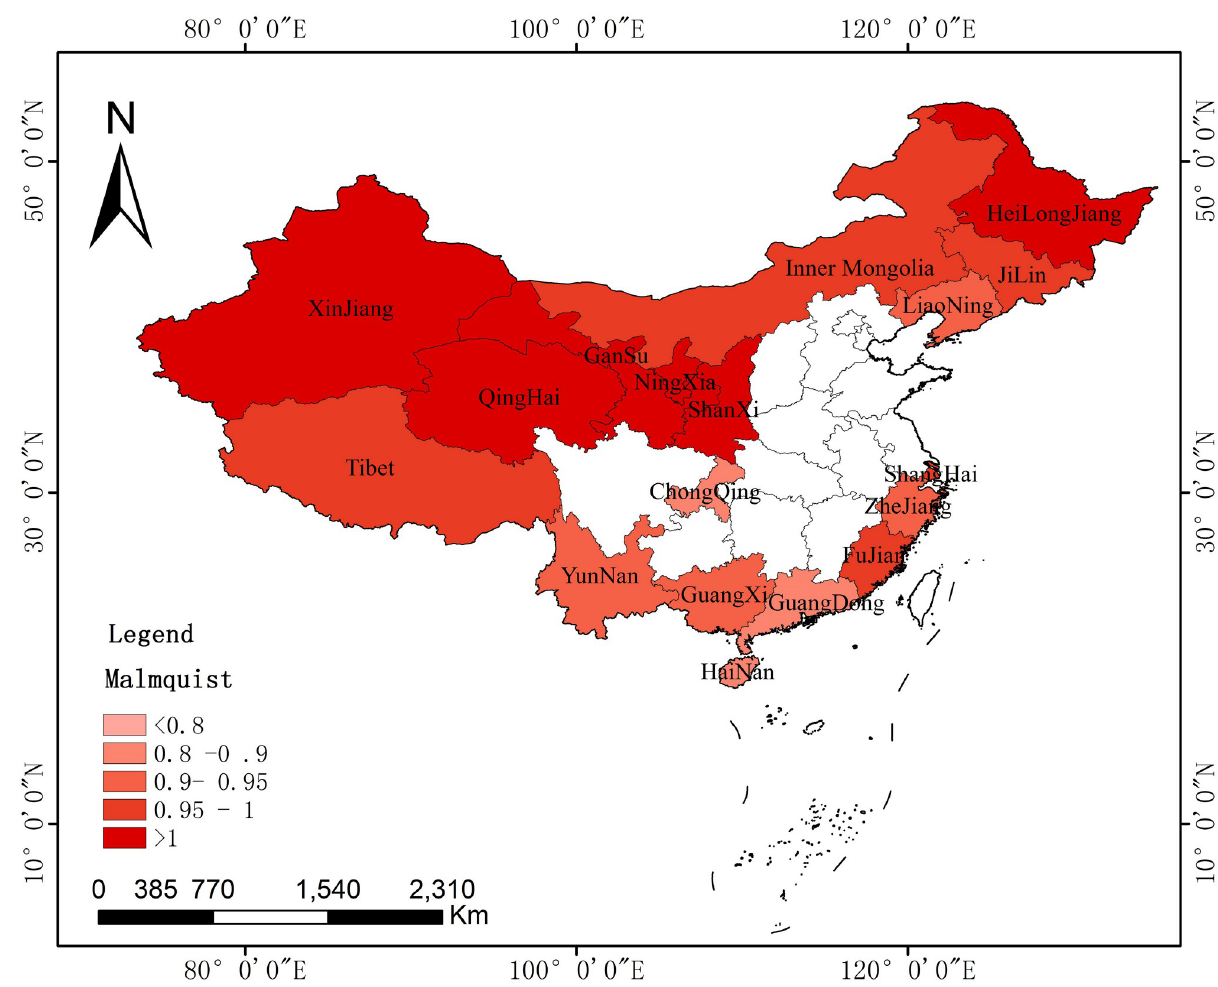
Fig 4. Spatial distributions of the Malmquist index of key provinces along the B&R in 2007.